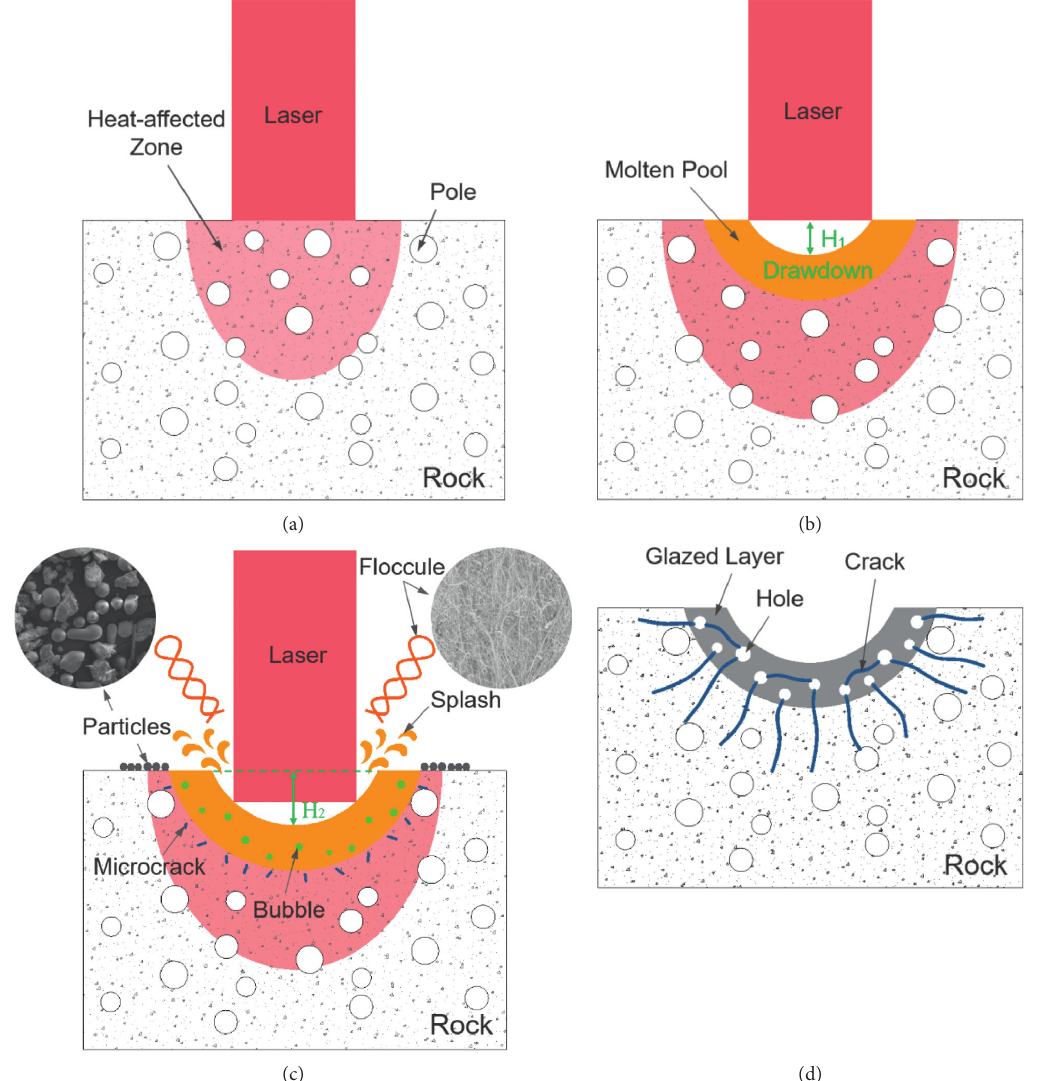
Figure 14: Schematic diagram of evolutionary process of the rock laser